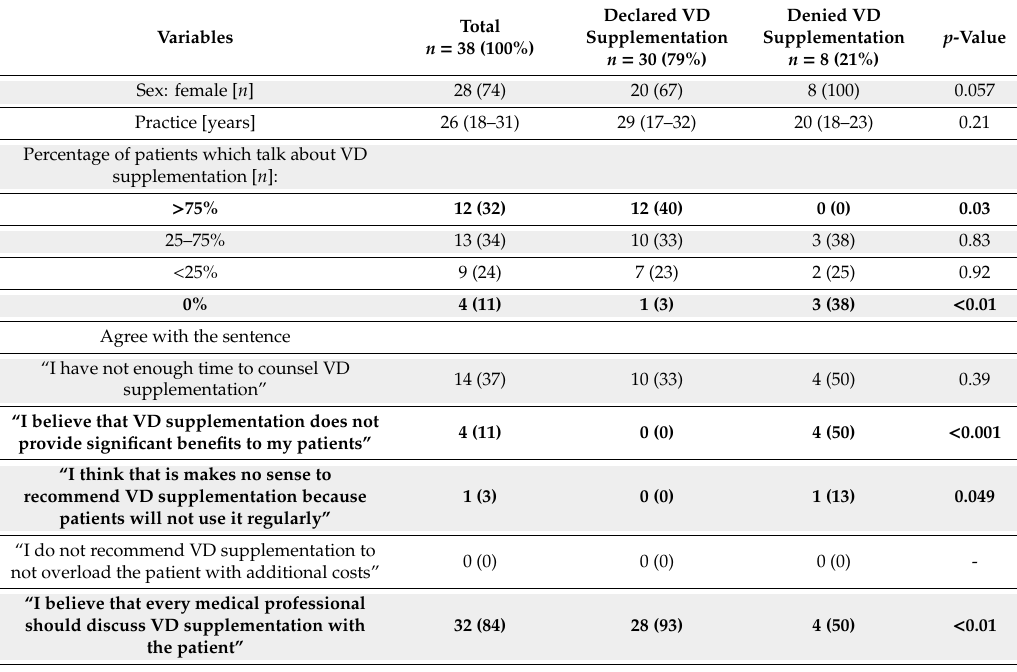
Table 2. Comparison between diabetologists who declared or denied vitamin D supplementation. Data presented as number (percentage) or median (interquartile